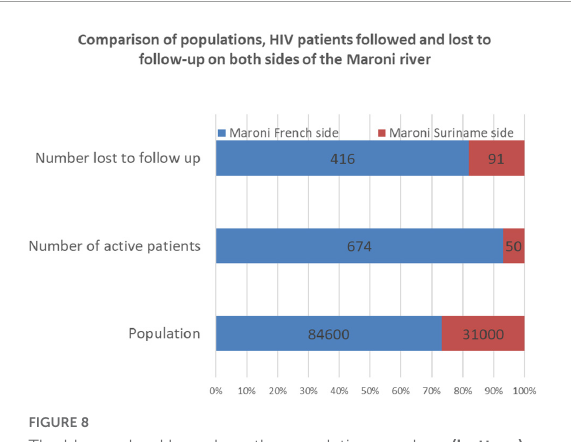
FIGURE7 The evolution of the number of HIV tests in the health centers on the French side of the Maroni river shows a general increase over time. The disruptions due to COVID-19 have however had an impact in Maripasoula and Papaïchton.